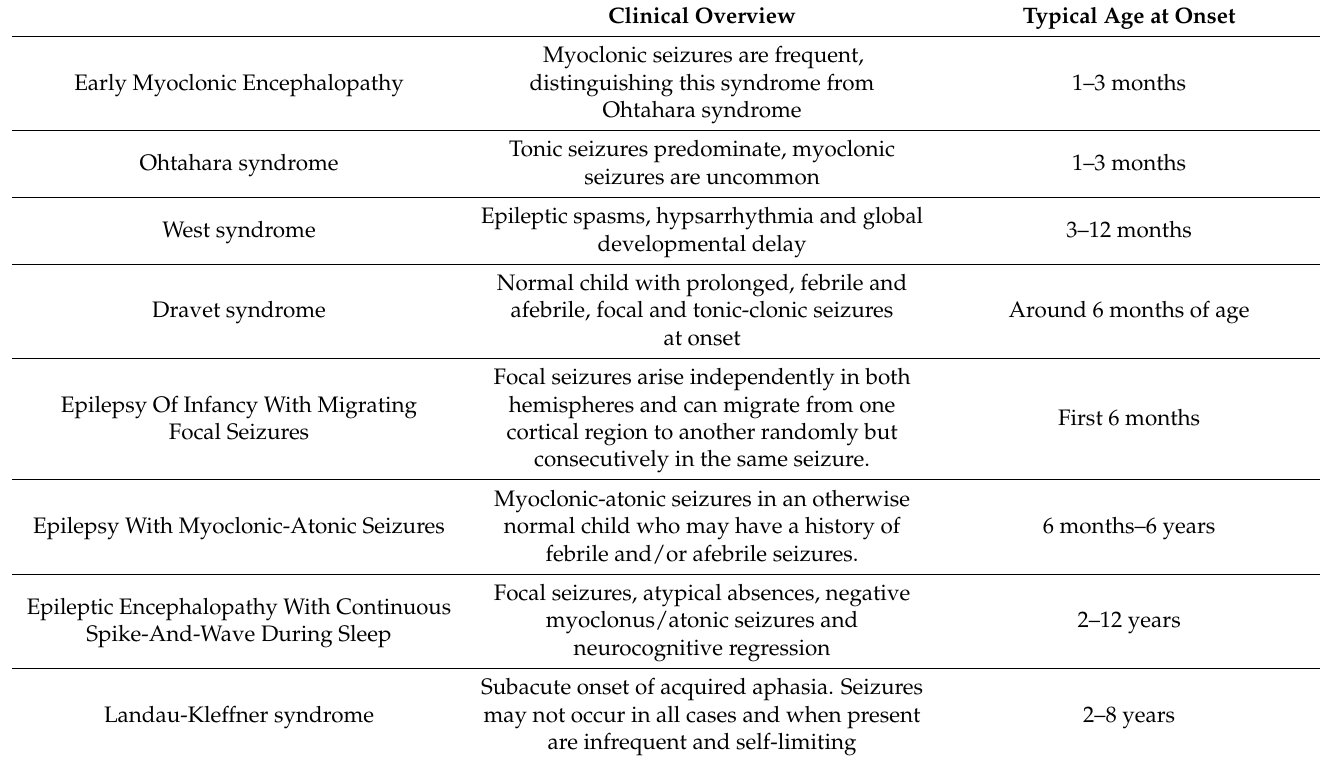
Table 1. Classical epilepsy syndromes corresponding to EE/DEE (modified from https://www.epilepsydiagnosis.org/) (accessed on 30 October